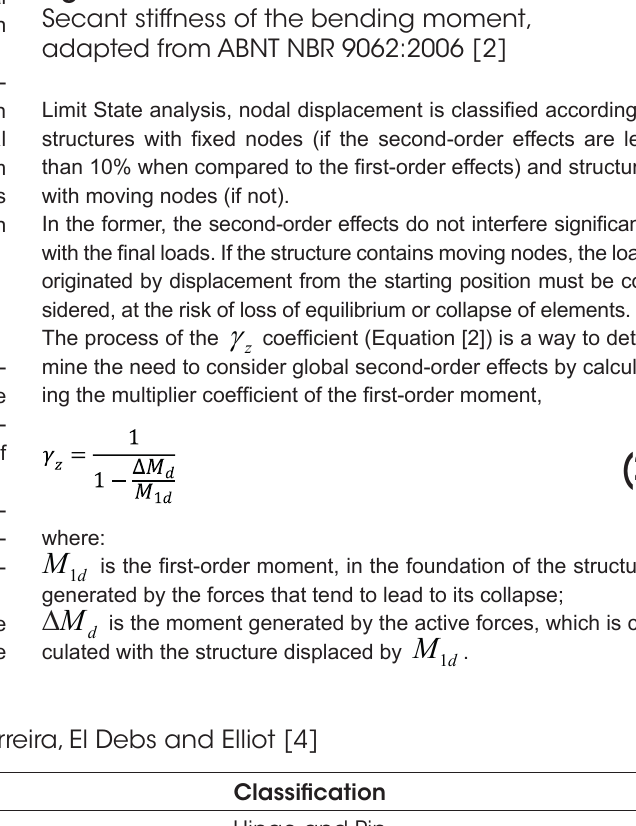
Classification of the connections adapted from Ferreira, El Debs and Elliot [4] Constraint factor α Zone Classification r I Hinge and Pin II Semi-rigid with low flexural strength III Semi-rigid with intermediate flexural strength IV Semi-rigid with high flexural strength